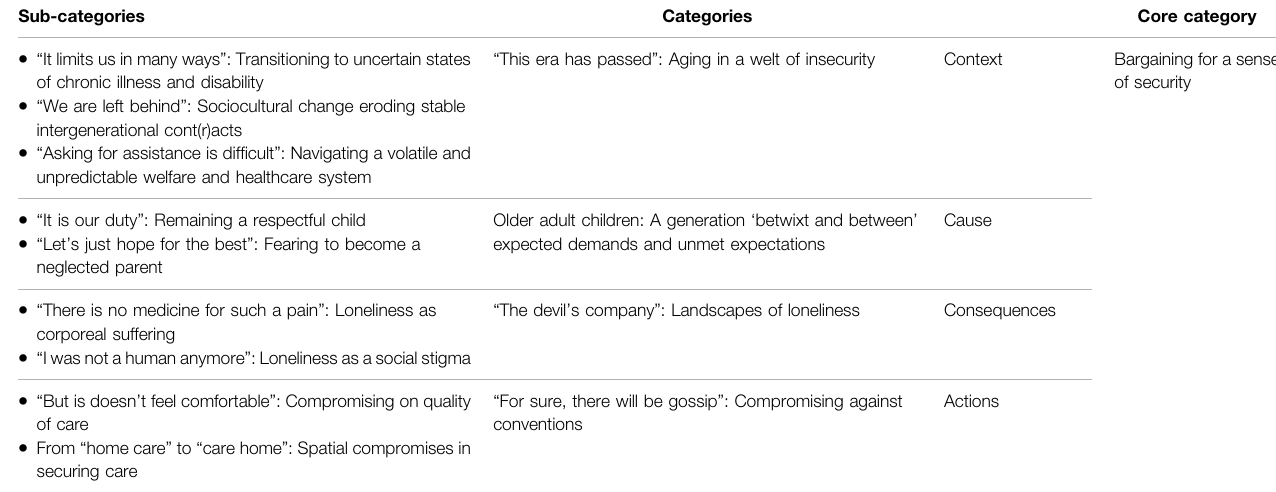
TABLE 3 | Overview of the core category, categories, and sub-categories and their position within the paradigm